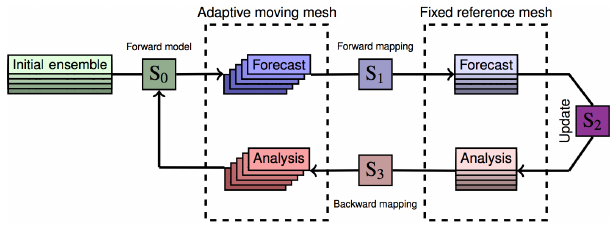
Figure 3. Illustration of the analysis cycle in the proposed EnKF method for adaptive moving mesh models. In S 1 , adaptive moving meshes are mapped onto the fixed reference mesh. The ensemble is updated on the fixed reference mesh at step S 2 (i.e., the analysis). Then, in S 3 the updated ensemble members are mapped back to the corresponding adaptive moving meshes. The full process is illus- trated in Fig. 4 for one ensemble member. See text in Sect. 5 for full details on the individual process steps, S 0 , S 1 , S 2 and S 3